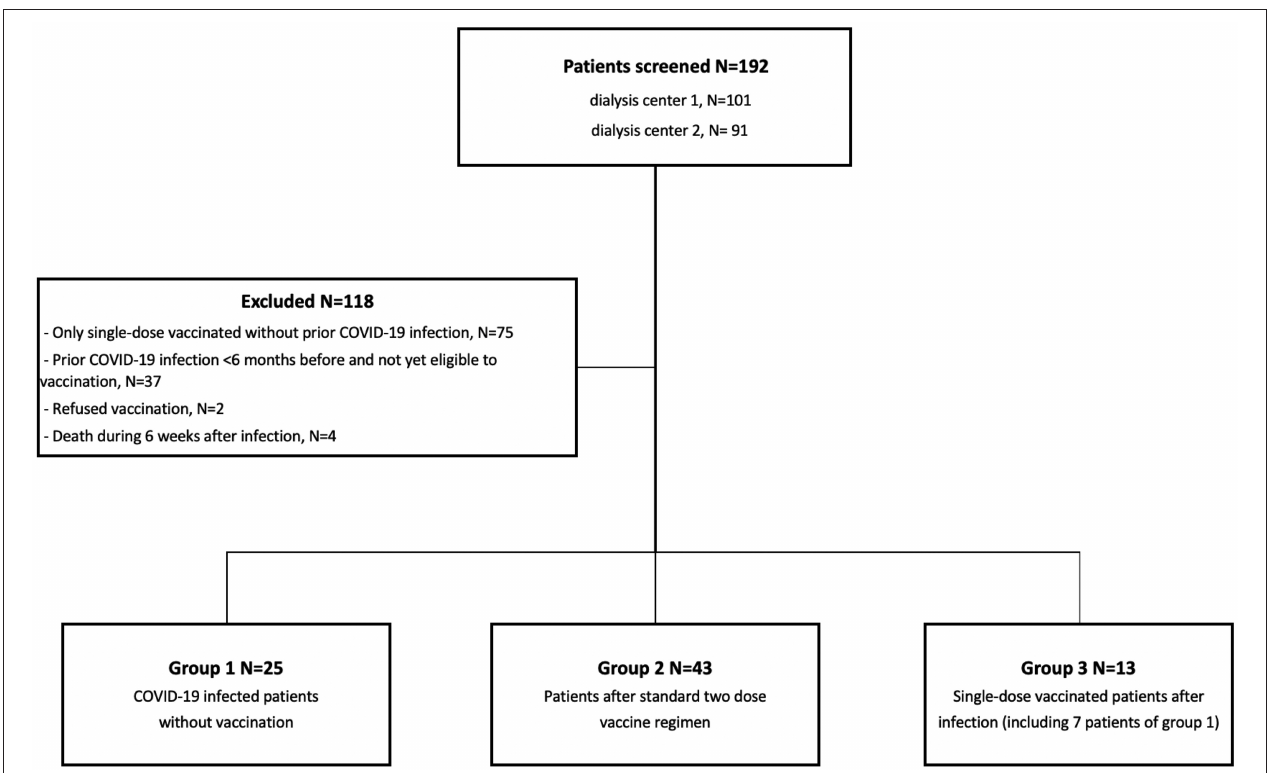
FIGURE 1 | Flowchart of study population selection including screening, exclusion, and patients eligible for study participation. One hundred and ninety-two patients were screened for study participation at two sites. One hundred and eighteen individuals were excluded, and the remaining 74 individuals were found to be eligible for study participation. Depending on COVID-19 infection or vaccination status, individuals were separated into three different groups, namely COVID-19 infected individuals, patients who received a full BNT162b2 vaccination, and previously COVID-19 infected individuals who received a single-dose vaccination. N indicates the number of individuals. a Group 3 contains seven patients of group 1 after single-dose BNT162b2